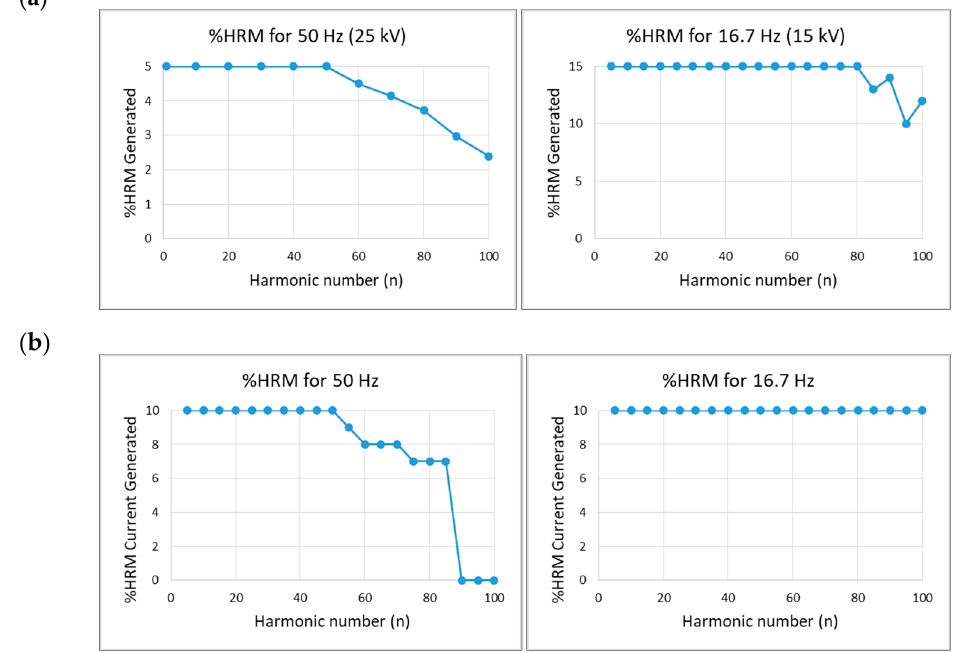
Figure 8. ( a ) Limits for voltage harmonic components, ( b ) Limits for current harmonic components. Note: HRM = Harmonic.